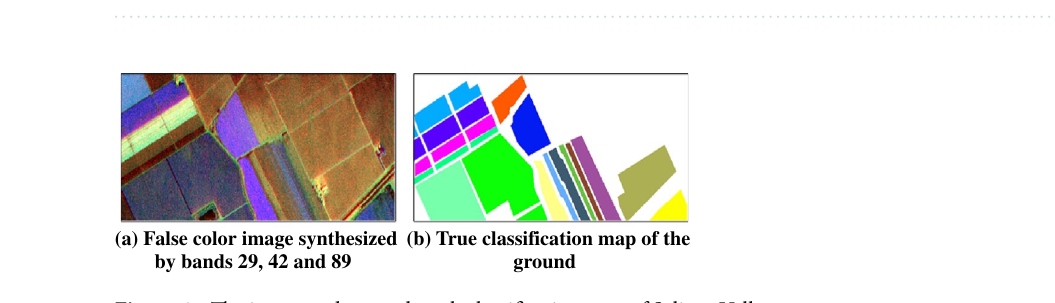
Figure 4. The image and ground truth classification map of Salinas Valley